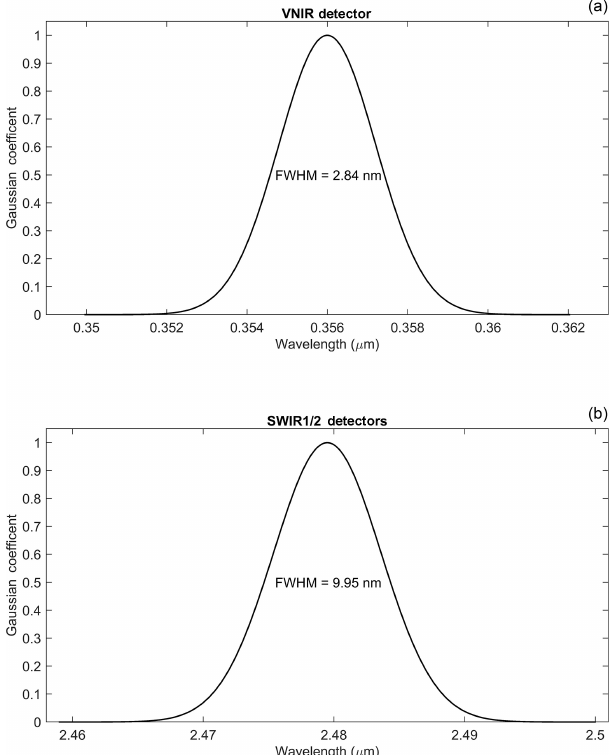
Figure 10. Gaussian spectral response functions for the airborne nadir-viewing spectrometer. Panel (a) shows the VNIR detector spectral response, and panel (b) shows the SWIR1/2 detector spec- tral response. Note: FWHM refers to full-width half-maximum re- sponse to a filter value of 1.0 on the center